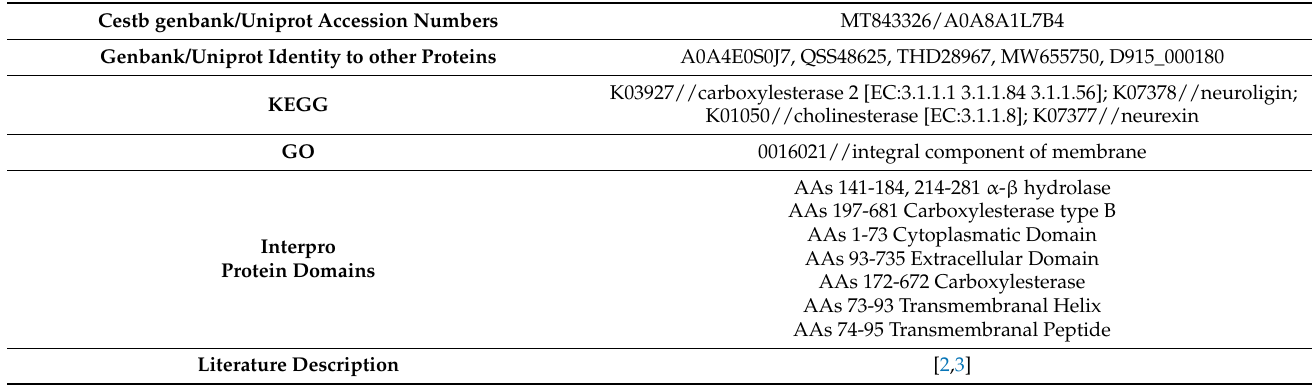
Table 1. Protein–enzyme characteristics of CestB obtained by bioinformatics. CestB E215 allele A0A8A1L7B4 and K215 allele A0A4E0S0J7 sequences were downloaded from www.uniprot.org (accessed on 10 September 2022). Gene Ontology Enrichment analysis (GO) was obtained from geneontology.org (accessed on 10 September 2022). KEEG orthology links were obtained from www.genome.jp/kegg/ko.html (accessed on 10 September 2022). Protein domains were obtained from www.ebi.ac.uk/interpro/ (accessed on 10 September 2022).